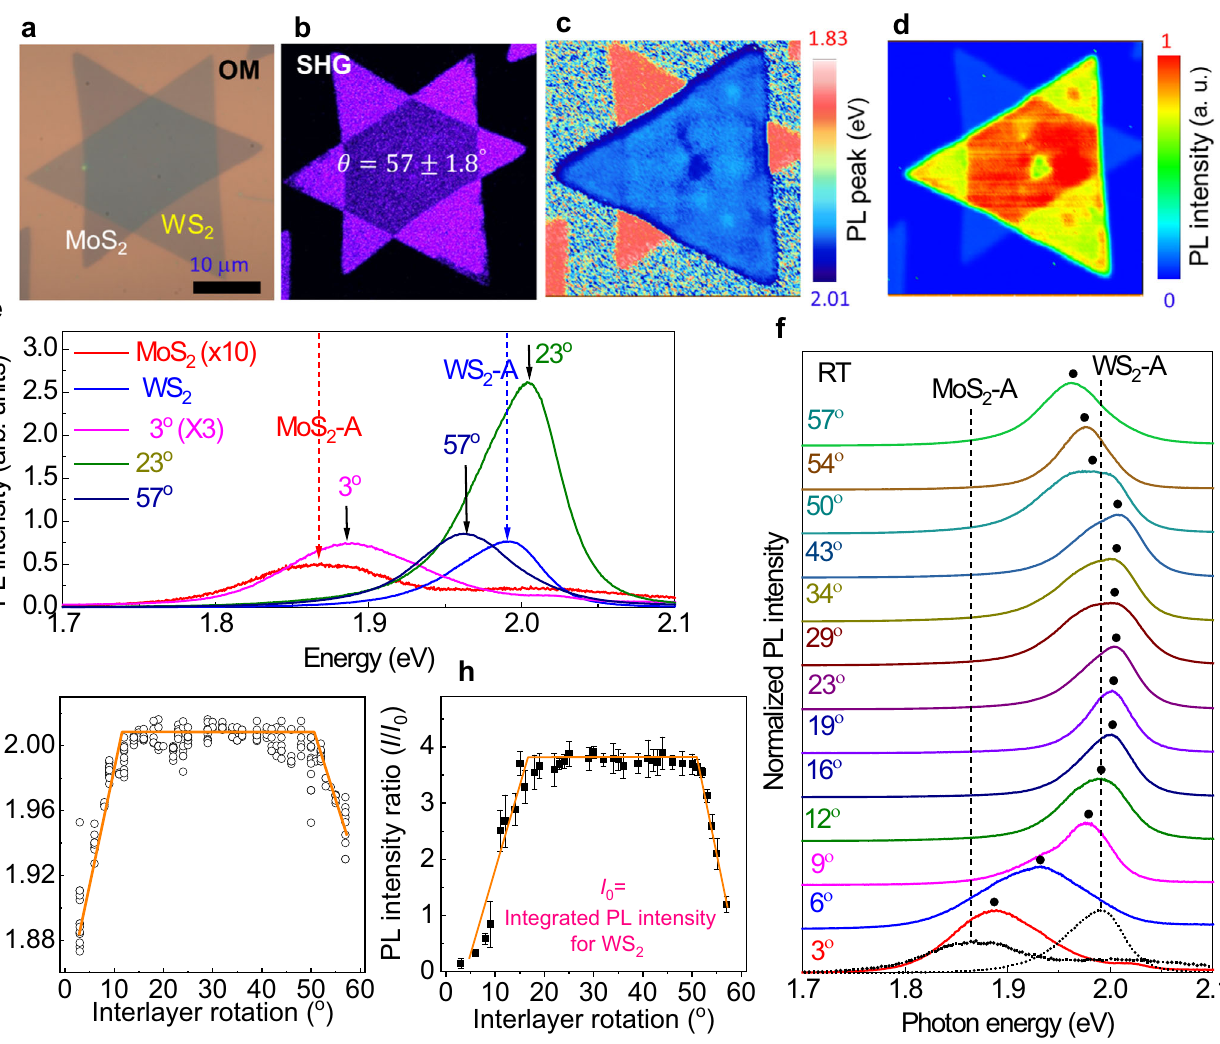
Fig. 2 Photoluminescence of twisted MoS 2 /WS 2 heterobilayers at room temperature. a – d Optical microscopy image ( a ) of a typical bilayer at θ = 57° and corresponding ( b ) SHG, ( c ) PL peak energy, and ( d ) PL peak intensity mapping images. e PL spectra of typical MoS 2 and WS 2 monolayers, and MoS 2 /WS 2 bilayers at θ = 3, 23, and 57°. Here, the PL peaks of the MoS 2 and WS 2 intralayer excitons (MoS 2 -A and WS 2 -A) are indicated. f Shifts of the PL spectra by successive variation of θ from 3 to 57°. Here, the locations of the WS 2 - A peak are drawn by the guiding line. g , h PL peak ( g ) energy and ( h ) intensity as a function of θ